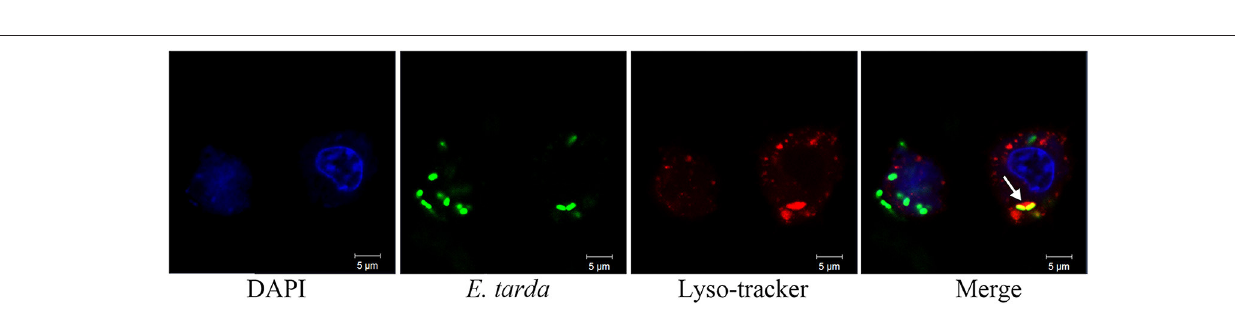
FIGURE 5 | Co-localization of Edwardsiella tarda with lysosomes in RAW264.7. RAW264.7 cells infected with E. tarda TX1G for 1.5 h were treated with Lyso-tracker red. The cells were stained with DAPI and observed with a confocalmicroscope. White arrow indicates co-localization of bacteria and